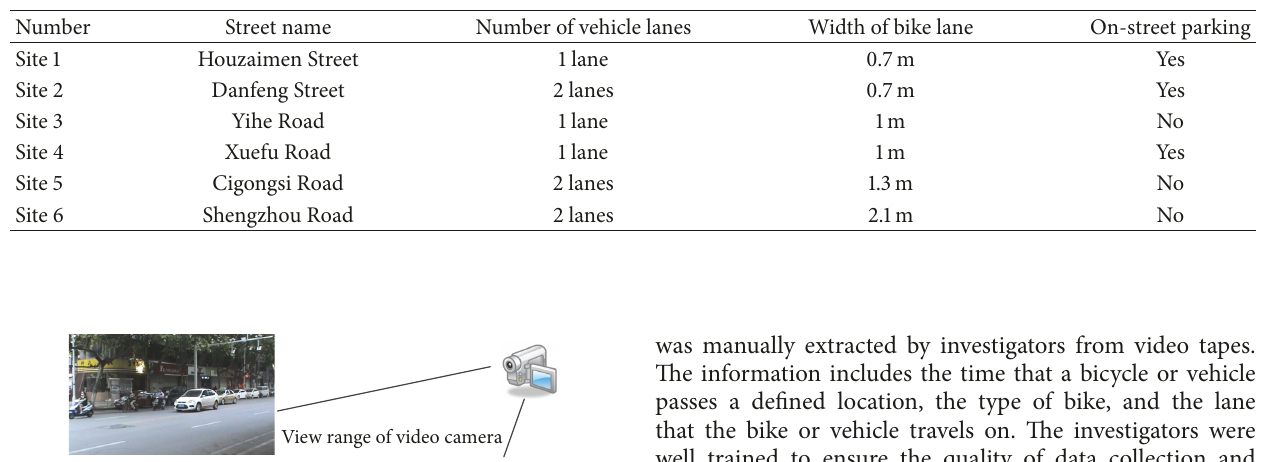
Table 1: Information about study sites.